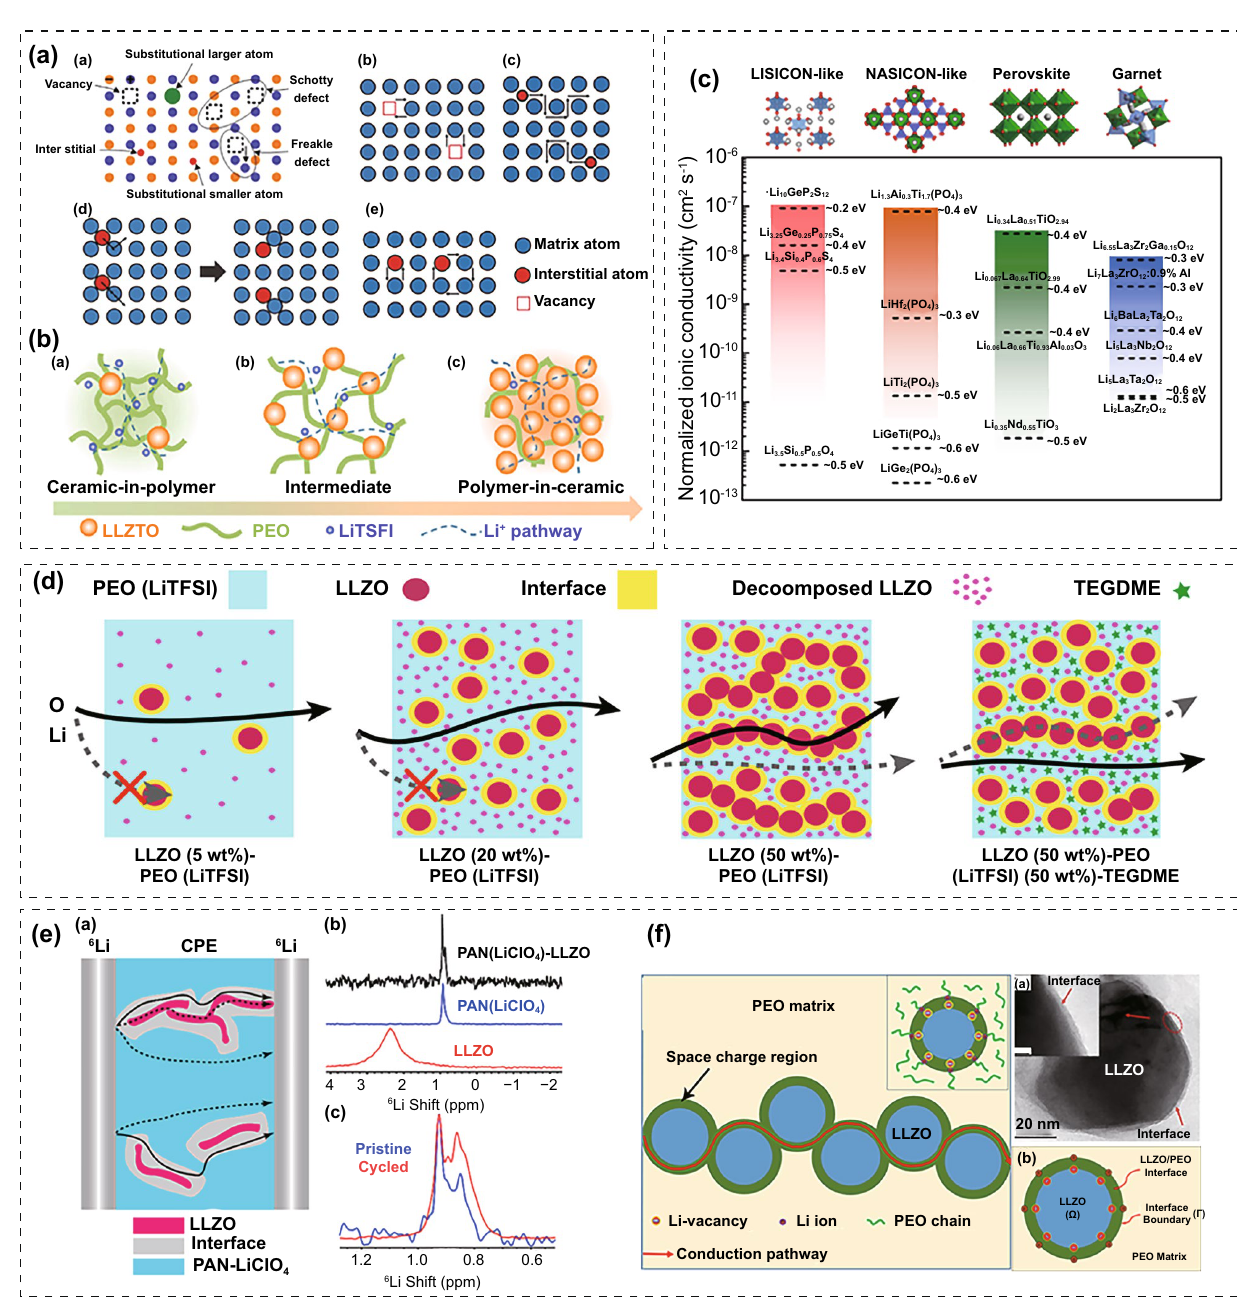
Fig. 9 a Diffusion modes of Li + ion in ISEs [28]. Copyright 2018, Royal Society of Chemistry. b Diffusion modes of Li + ion in PIEs with active fillers [155]. Copyright 2018, Elsevier. c Crystal structure, conductivity and activation energy of different active fillers [156]. Copyright 2016, American Chemical Society. d Schematic diagram of Li + ion diffusion routes in PEO-LiTFSI with different contents of LLZO fillers [157]. LiClO 4 @LLZO, LLZO nanowires, PAN-LiClO 4 and cycled PIEs [158]. Copyright 2017, American Chemical Society. f Schematic of the rapid ion diffusion route in space charge regions and the TEM image of space charge regions [159]. Copyright 2019, American Chemical